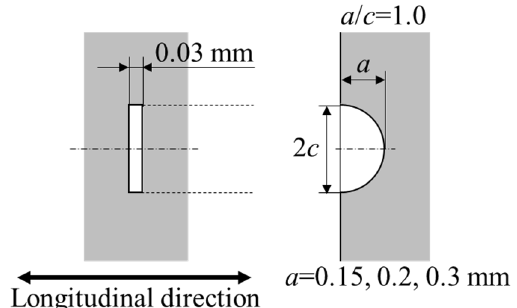
Figure 4. Shapes and dimensions of the artificial defect.